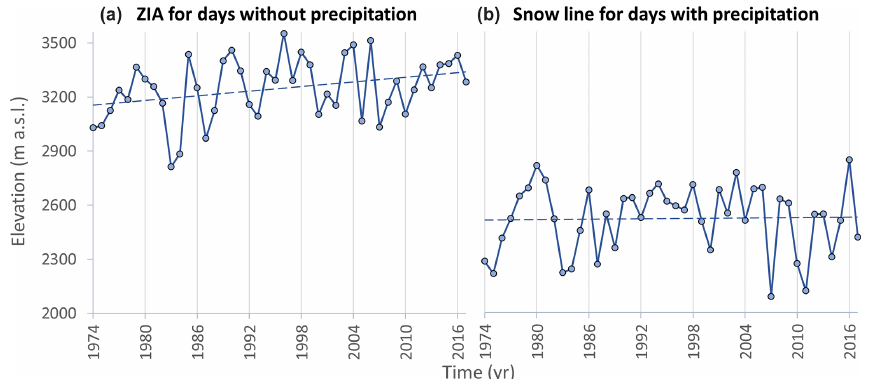
Figure 8. Warming effects. (a) Annual series for the May–September average of the zero-degree isotherm altitude during dry days. (a) Annual series for the May–September average of the snow line during days with precipitation. Dashed lines indicate the trends.